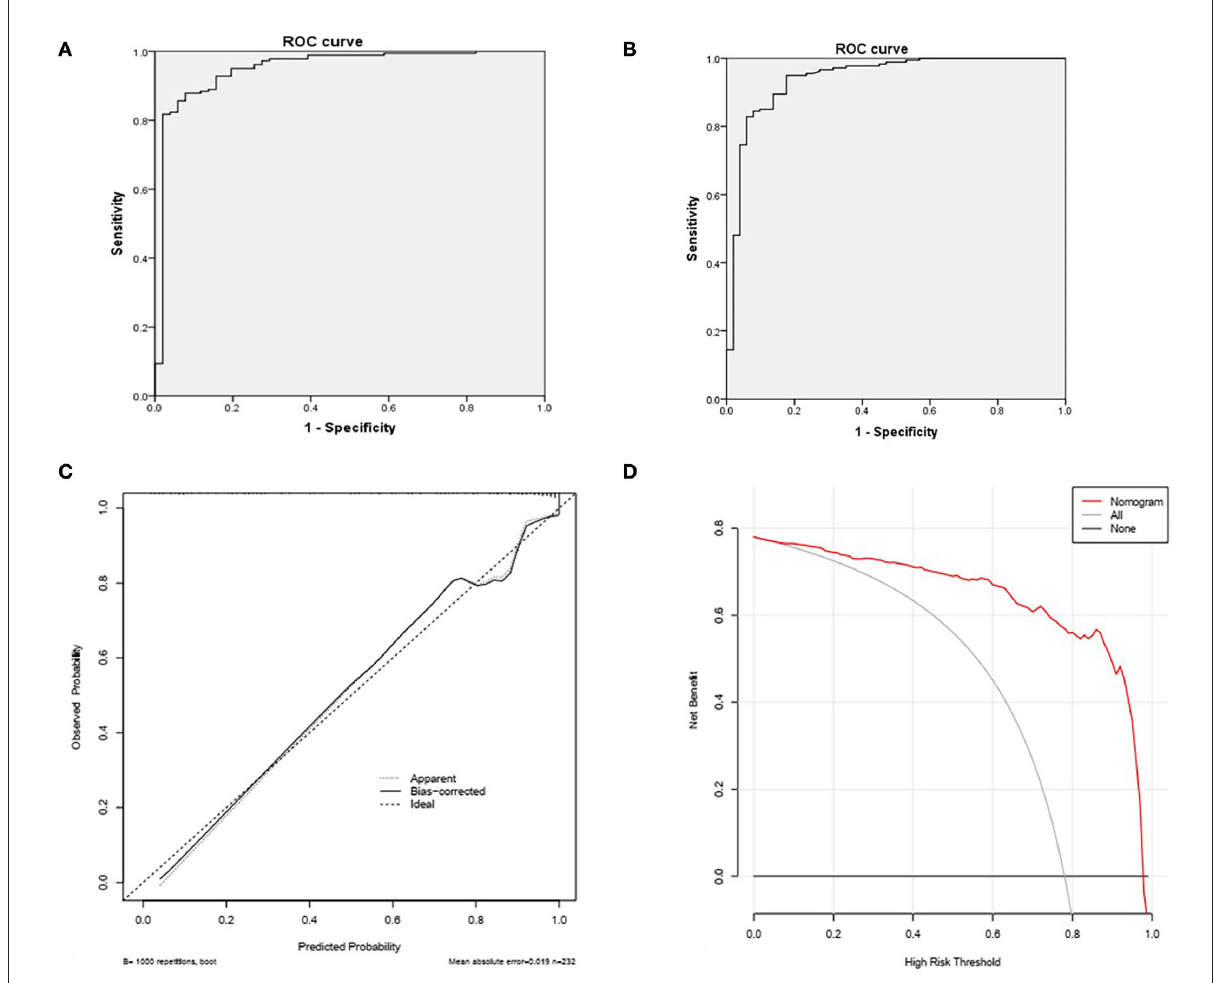
FIGURE2 (A) The area under ROC curve of Model 1 was 0.950. The sensitivity was 95.0% and the specificity was 82.4%. (B) The area under the ROC curve of Model 2 was 0.941. The sensitivity was 92.8% and the specificity was 84.3%. (C) The Bootstrap method, repeated sampling 1000 times, was used for validation, and the C-index value was 0.94. (D) In the range of 0.01–1, the net benefit rate of the model 2 that predicts NGT removal in PSD patients is >